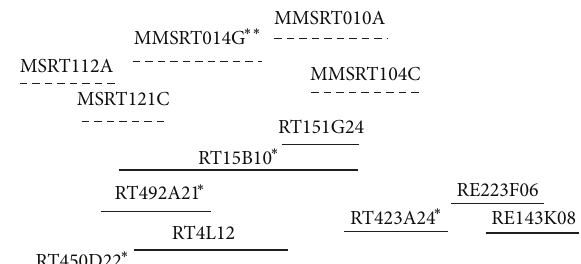
Figure 1: Diagram of the OmyY1 BAC contig showing clones that we examined in this project. The dashed lines above the BAC clones indicate Scaffolds from Mike Miller’s rainbow trout genome assembly. ∗ Indicates that the clone was sequenced by Illumina. ∗∗ Indicates scaffolds that did not include BACs known to be in the OmyY1 contig (6256), but which apparently had BACs that areinthisregionbecausesequencesofgenesidentifiedintheOmyY1 BACs matched the sequence of genes in these scaffolds exactly.